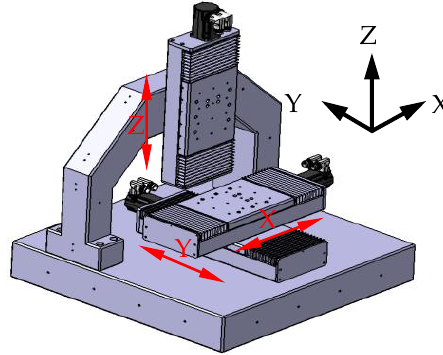
Figure 3. The structure of the 3-axis machine tool.